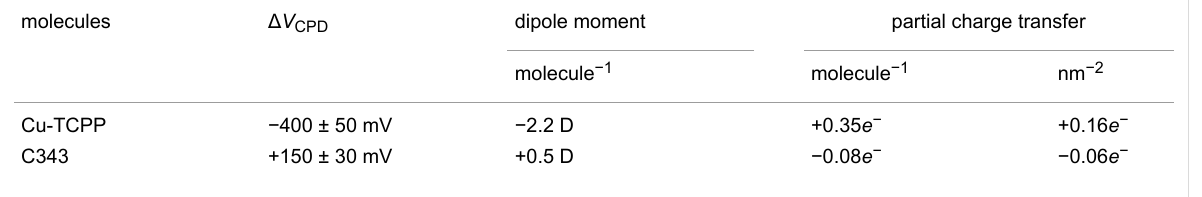
Table 3: Comparison between Cu-TCPP and C343 adsorbed on NiO(001). molecules Δ V CPD dipole moment partial charge transfer molecule − 1 molecule − 1 nm − 2 Cu-TCPP − 400 ± 50 mV − 2.2 D +0.35 e − +0.16 e − C343 +150 ± 30 mV +0.5 D − 0.08 e − − 0.06 e